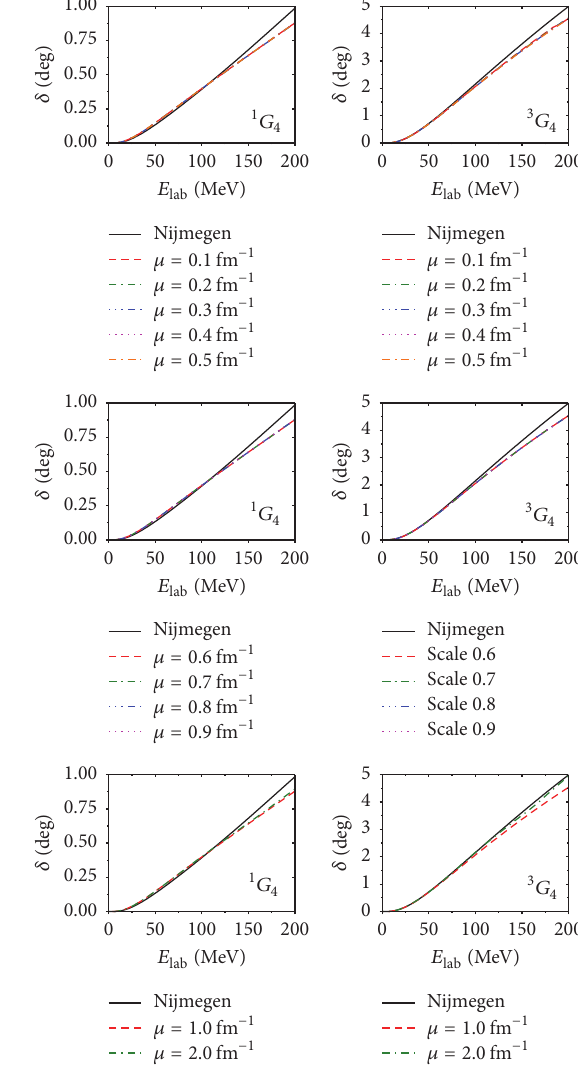
Figure 7: (Color on-line) phase shifts in 1 𝐹 3 and 3 𝐹 3 channels calculated from the solution of the subtracted LS equation for the 𝐾 -matrix with five subtractions for the N3LO-EGM potential for several values of the renormalization scale compared to the Nijmegen partial wave analysis.